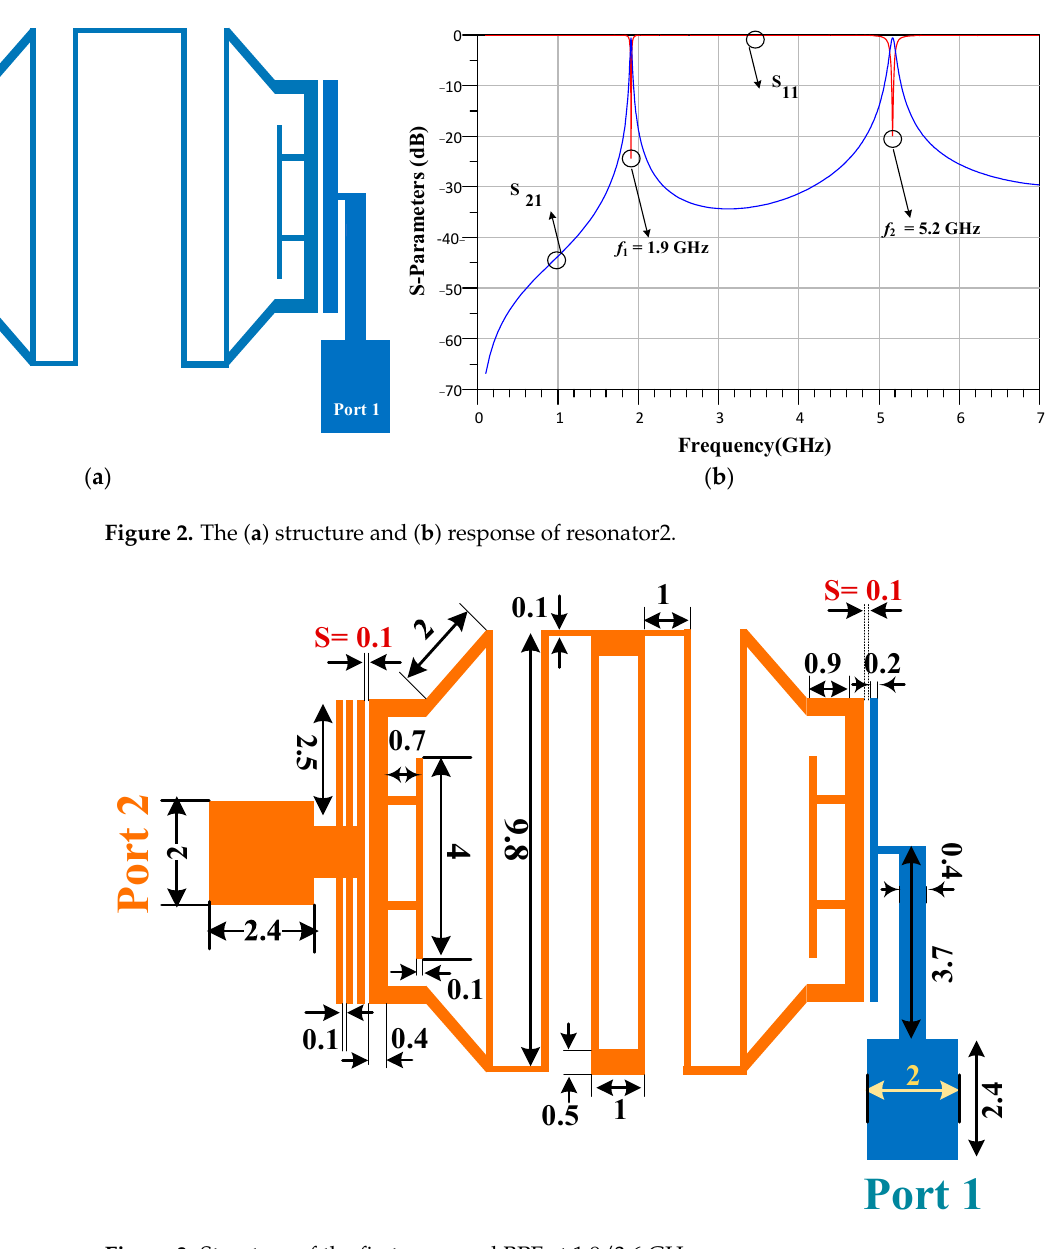
Figure 3. Structure of the first proposed BPF at 1.9/3.6 GHz.